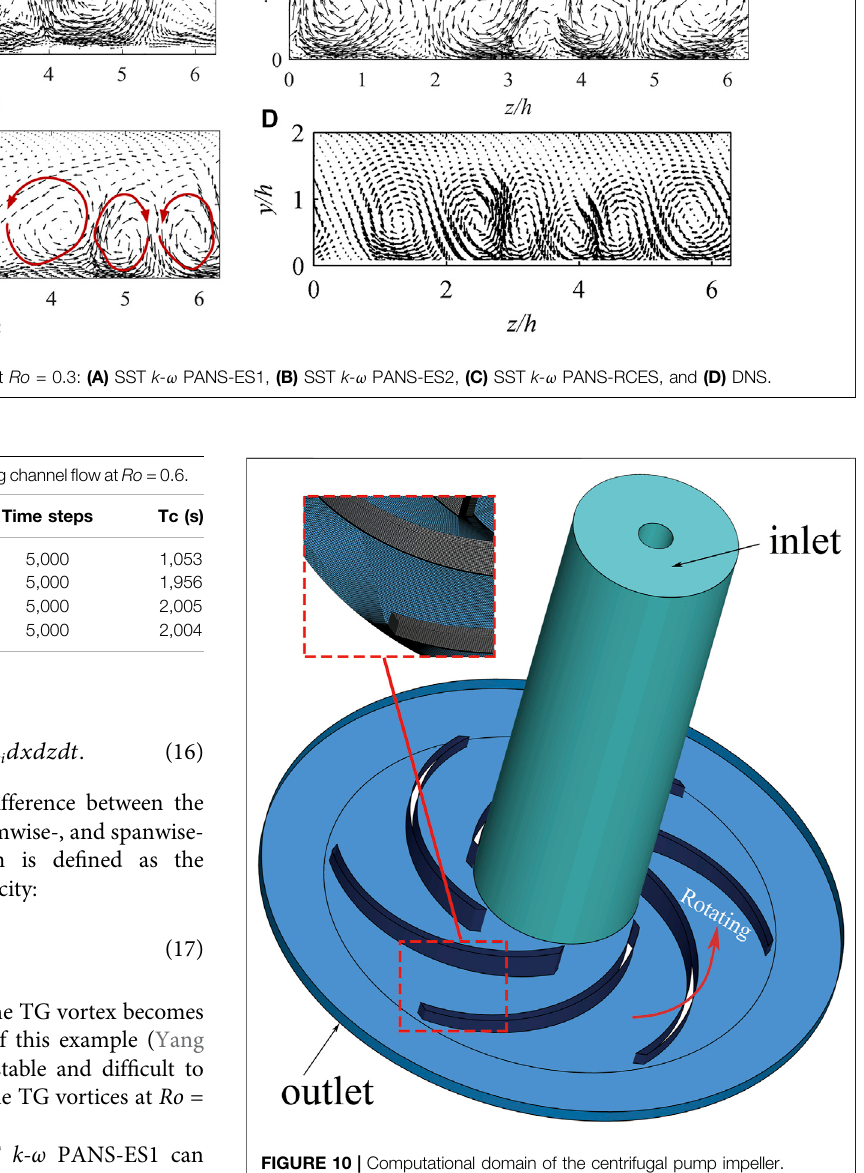
FIGURE 10 | Computational domain of the centrifugal pump